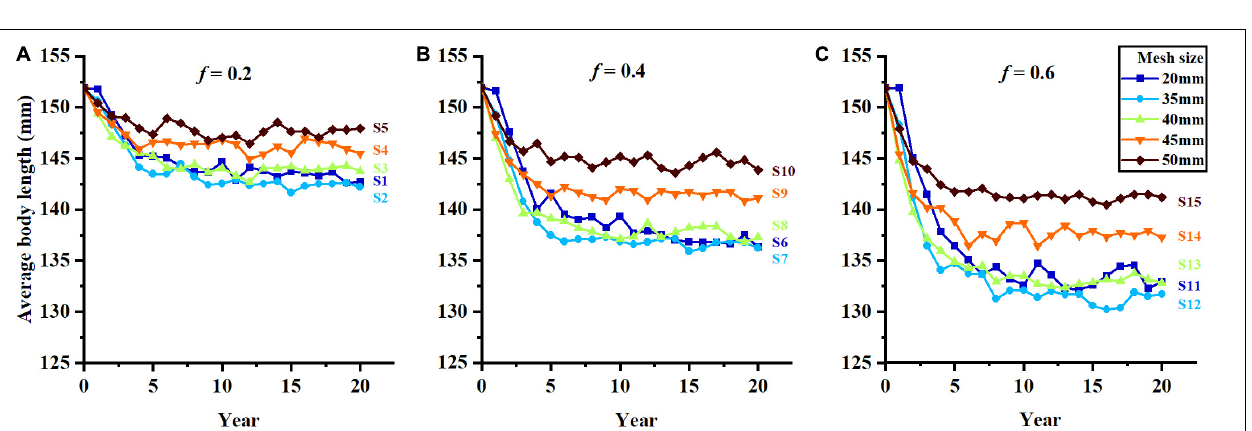
FIGURE 3 | The change of biomass in different harvest scenarios, (A–C) represent f = 0.2, f = 0.4, and f = 0.6.